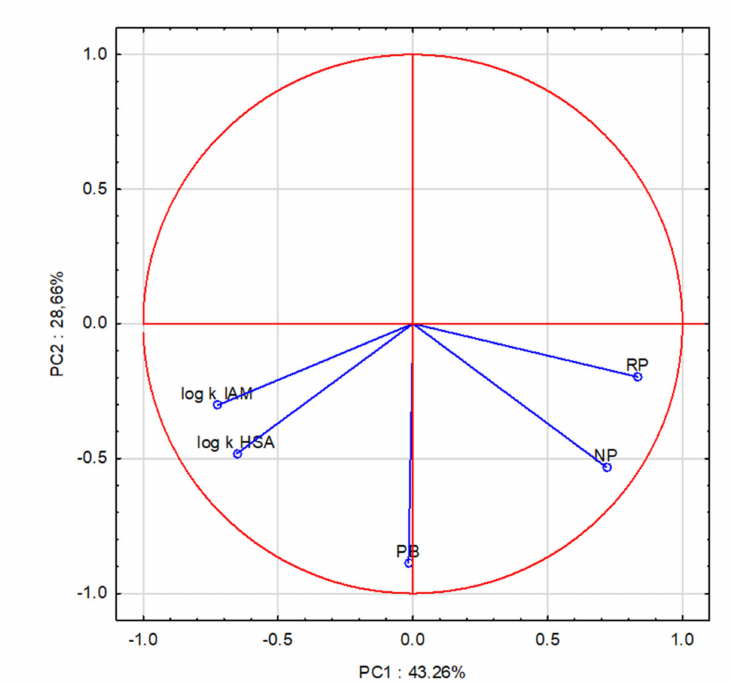
Figure 3. Projection of variables on the plane of factors PC1 ×